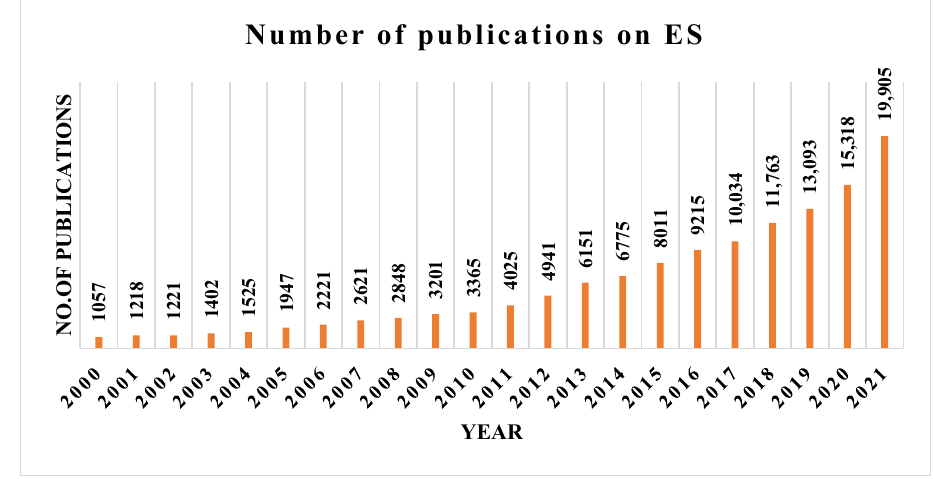
Figure 2. Number of publications on ecosystem services for two decades.